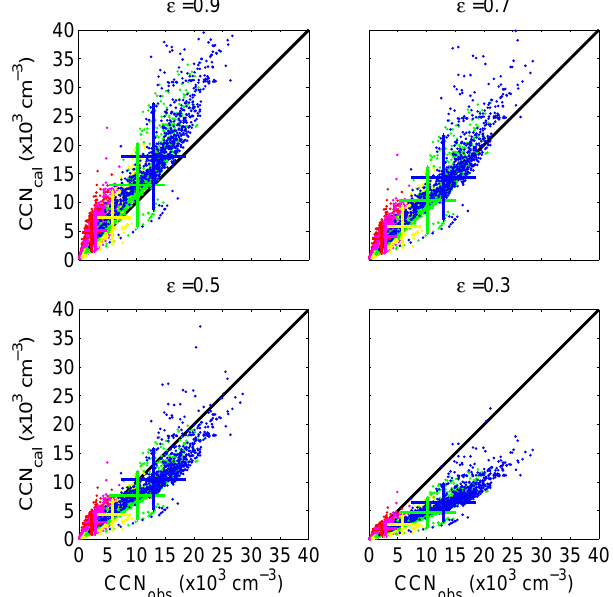
Fig. 2. Comparison between the calculated and observed CCN num- ber concentration for four different mass fractions of ammonium sulfate ( ε) at different supersaturations. For each aerosol, ammo- nium sulfate is assumed to be internally mixed with an insoluble core. Colour coding of supersaturations and the representation of mean and standard deviation is as in Fig. 1.